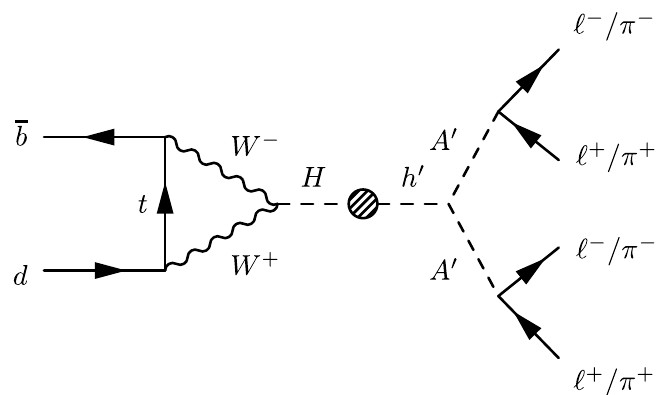
Figure 1 . A possible diagram of B 0 → A 0 A 0 decay through off-shell Higgs-dark Higgs mixing indicated by the shaded